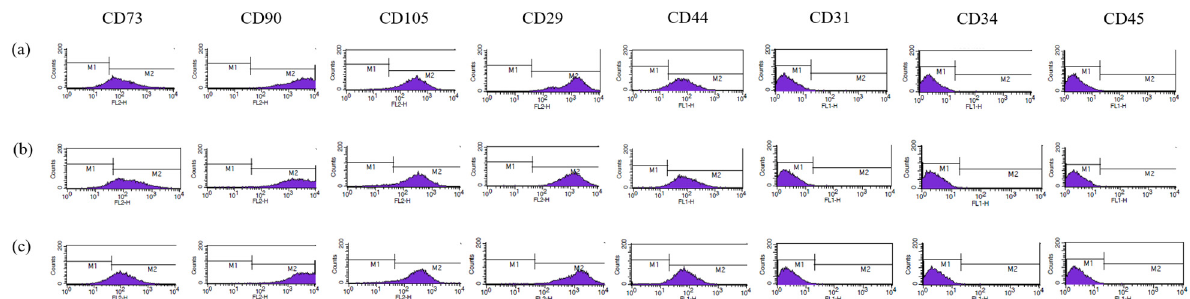
Figure 1. Characterization of human amniotic membrane-derived mesenchymal stem cell (AMSC). AMSCs isolated from three donors ( a – c ) were positive for CD73, CD90, CD105, CD29, CD44, and negative for CD31, CD34, and